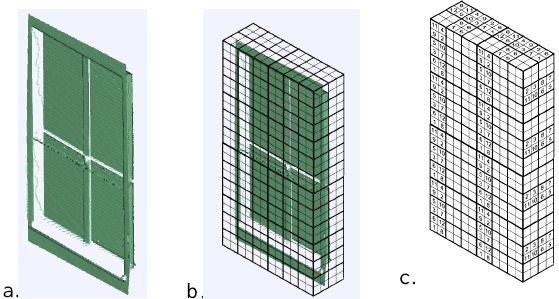
Figure 4. Example of a volumetric representation of a window: the original point cloud (a), the voxel splitting (b) and the final tensor representation v i